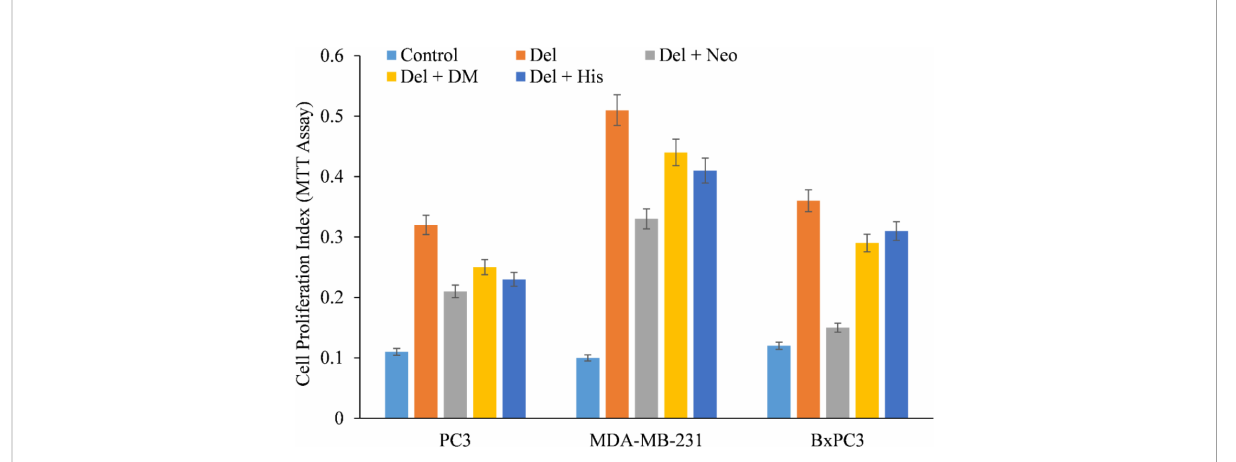
FIGURE 5 Effect of various metal chelators on delphinidin-induced apoptosis in three distinct cancer cell lines. As depicted in the fi gure, PC3, MDA-MB- 231, and BxPC3 cancer cells were treated with 50 µM of delphinidin alone or in the presence of the copper chelator neocuproine (Neo), the iron chelator desferrioxamine mesylate (DM), or the zinc chelator histidine (His). The concentration of metal chelators utilized was 50 µM. After 72 hours of treatment, MTT assay was performed as indicated in “ Methods. ” p ≤ 0.01 when compared to respective untreated control was treated as signi fi cant.